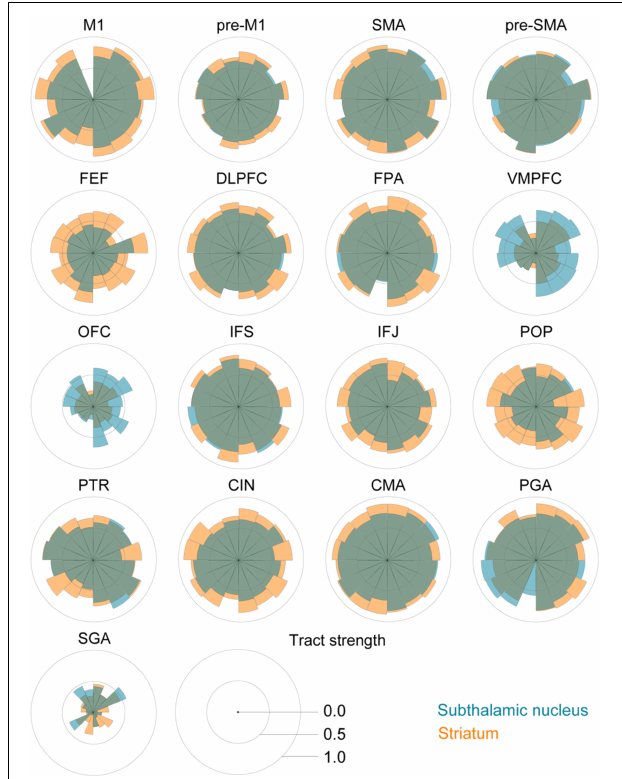
FIGURE 2 | Star plots of the tract strengths between the STN, STR, and the different cortical regions per participant. The STN is color coded using blue, the STR using orange, and both tracts are plotted with 50% opacity. Each segment corresponds to an individual